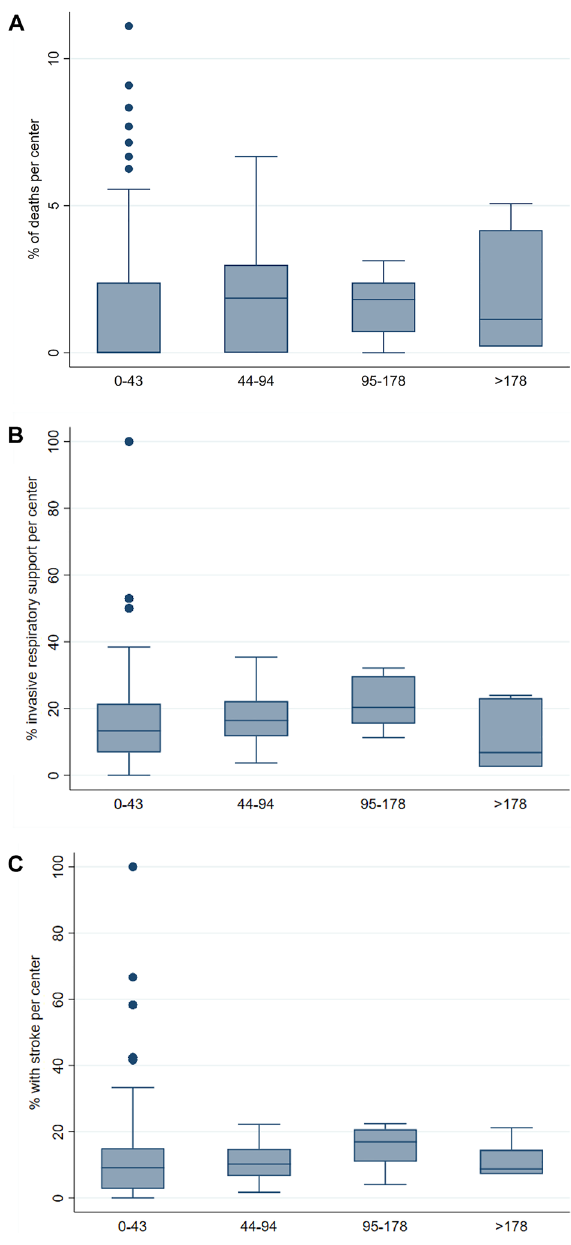
Figure 1. Box-whisker plot of percent of deaths per center, percent of patients with need for invasive respiratory support and percent of patients with stroke by quartiles of center volume. The vertical axis represents percentage of all patients reported from each center from 2012 to 2019. ( A ) Mortality; ( B ) need for invasive respiratory support or ( C ) stroke. The horizontal axis represents the number of admissions per center displayed by quartiles (see Table 1 for numeric quartile cutoffs and number of centers per quartile). The data are presented as box-whisker plots with the grey boxes representing the 25–75% percentiles of the data and the whiskers representing the 10% and 90% percentiles accordingly. Data outside the 90% are plotted individually. For each plot, by Kruskal–Wallis testing, the distributions for each quartile are different (p <